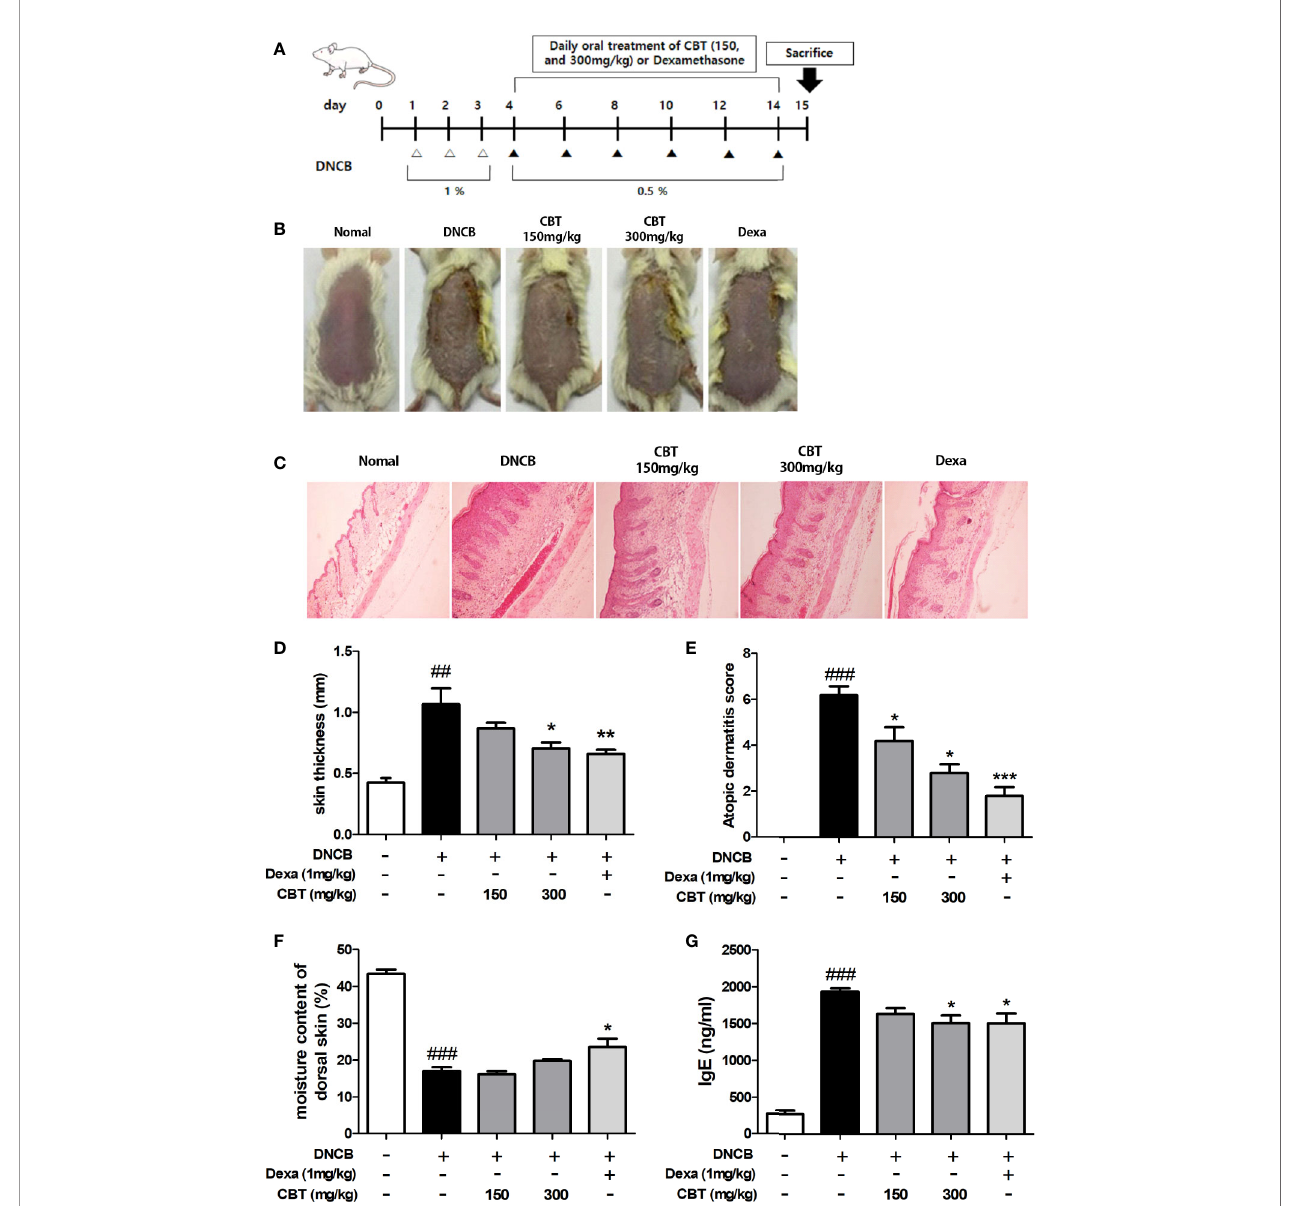
FIGURE 4 | Effects of Chijabyukpi-tang (CBT) on clinical signs in 2,4-dinitrochlorobenzene (DNCB)-treated mice skin tissues. The DNCB treatment and oral administration (CBT 150 and 300 mg/kg, and Dexa) schedule used in this experiment (A) . On the last day of the experiment, photographs were taken for comparison of skin lesions before the mice were sacri fi ced. Each dorsal skin picture is representative of each group (B) . The histological status of the dorsal skin tissues was observed using hematoxylin and eosin (H&E) staining (C) . Images were taken at 100x magni fi cation. The dorsal skin tissue thickness of mice was measured using a micrometer (D) . The atopic dermatitis score of mouse dorsal skin lesion was evaluated using the standard evaluation criteria (E) . The moisture content of mouse dorsal skin was measured using a Tewameter TM 210 device (F) . Serum IgE level was analyzed using enzyme-linked immunosorbent assay (ELISA) (G) . Data are shown as mean ± SEM of the three independent experiments. ### p < 0.001 compared with the control group, *p < 0.05, **p < 0.01, and ***p < 0.001 compared with the DNCB-induced group. The Dexa group was set as positive